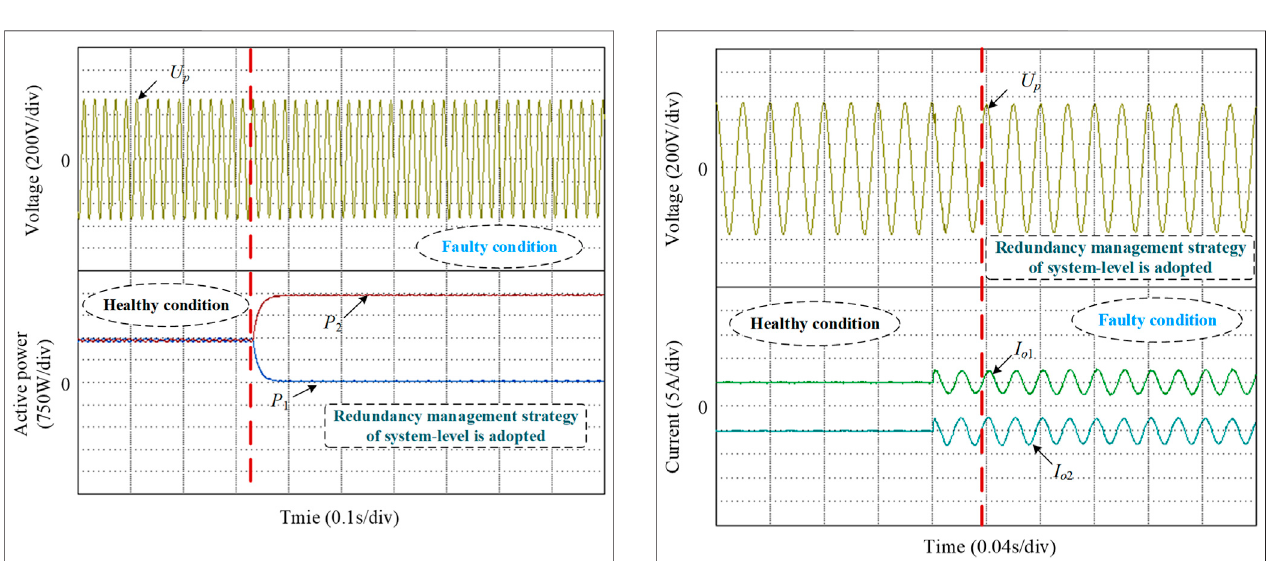
FIGURE 10 | Waveforms of active power and voltage (short-circuit fault of the power switch). FIGURE 11 | Voltage and current waveforms (open-circuit fault of Si